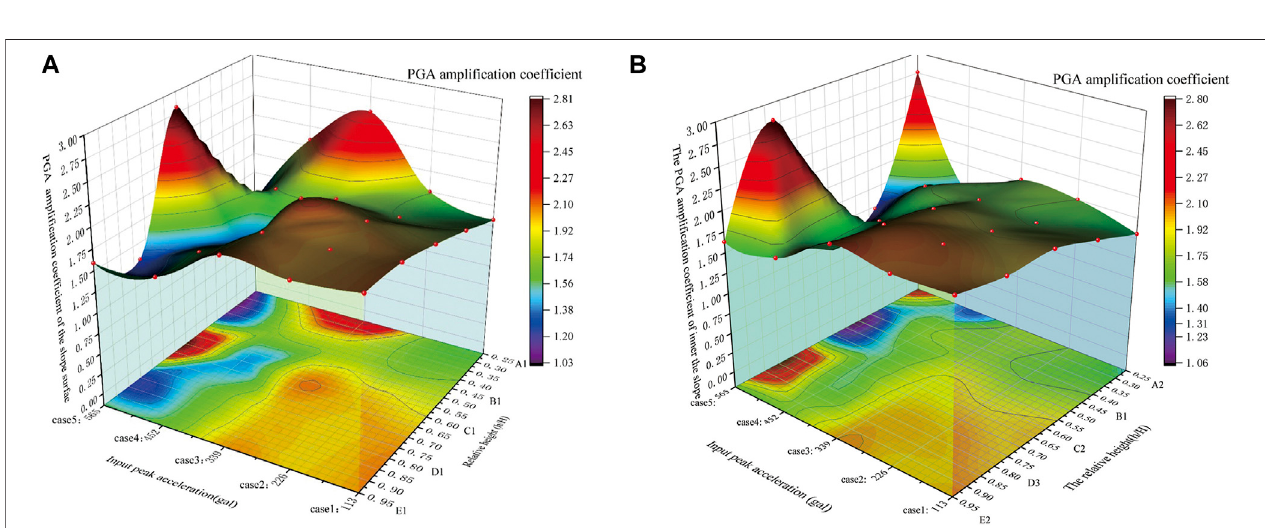
FIGURE6 | The PGA ampli fi cation coef fi cient against the input peak accelerationand relative height. (A) The PGAampli fi cation coef fi cientofthe slope surface. (B) The PGA ampli fi cation coef fi cient inside the slope.